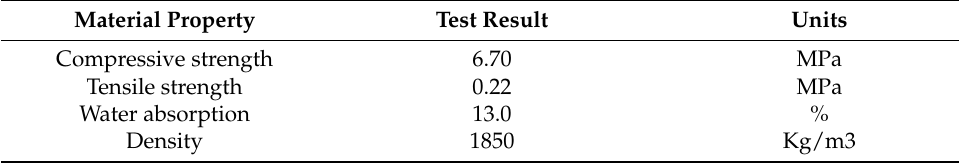
Table 2. Properties of CCI bricks.